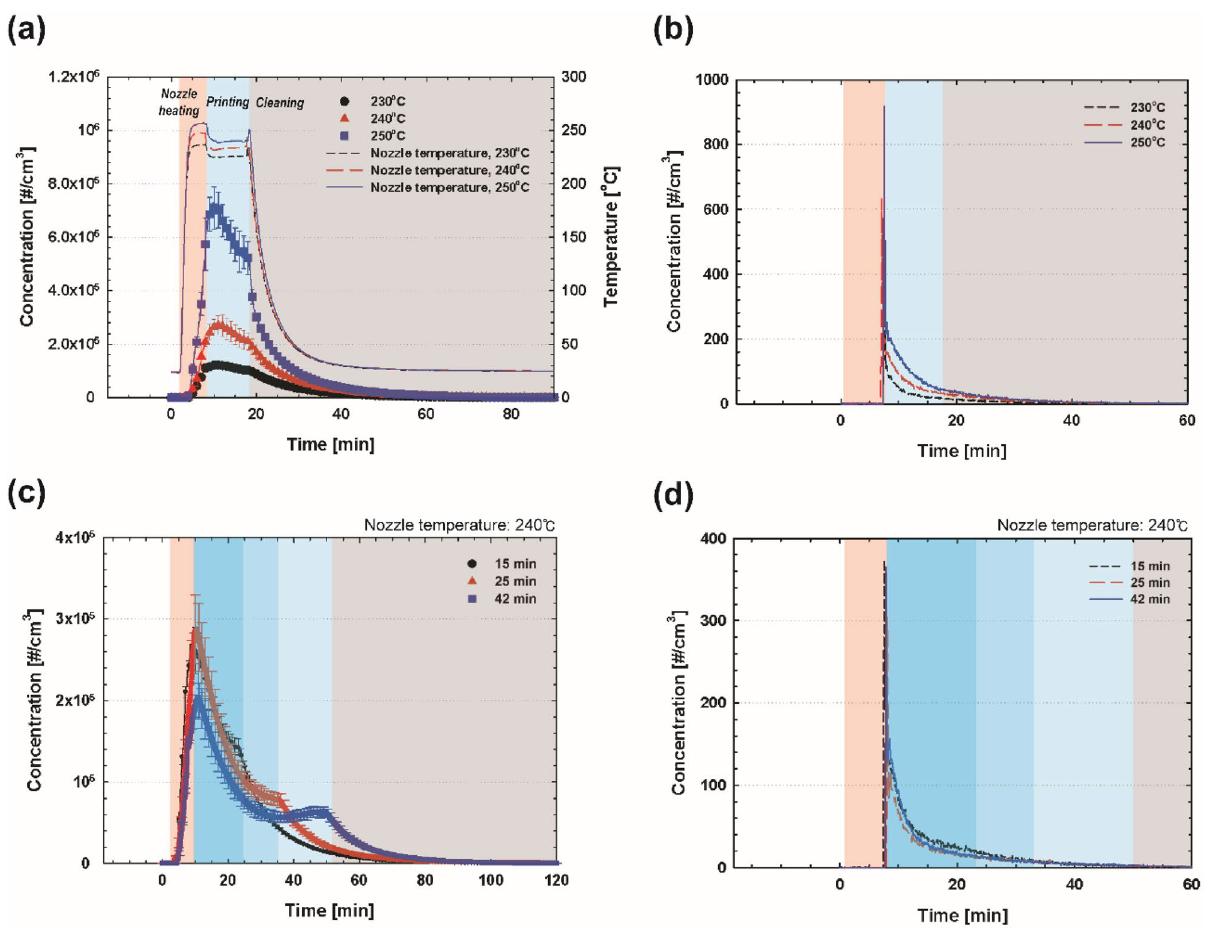
Figure 6. Concentrations of emissions from the ABS filament for different ( a , b ) nozzle temperatures and ( c , d ) printing times. ( a ) and ( c ) were obtained using a CPC, and ( b ) and ( d ) were obtained using an OPC. The red, blue, and gray shaded areas represent the process of nozzle heating, printing, and cleaning,